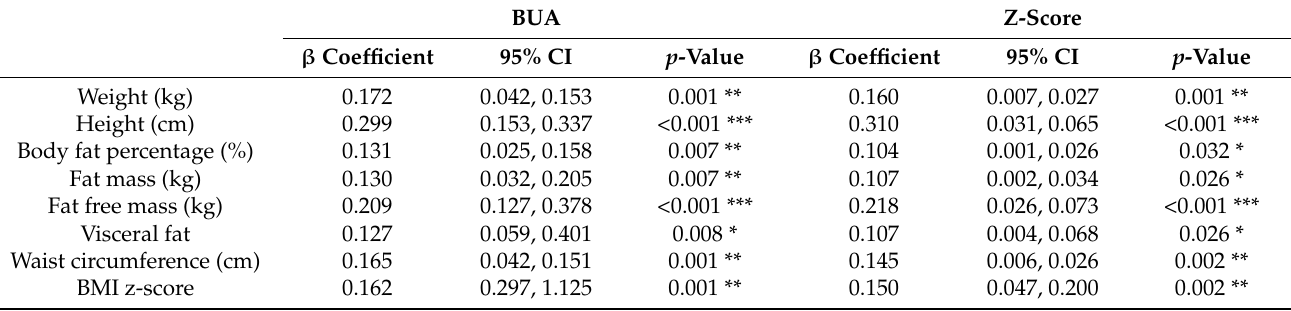
Table 4. Linear regression analysis models for bone outcome variables predicted by body composition variables. BUA β